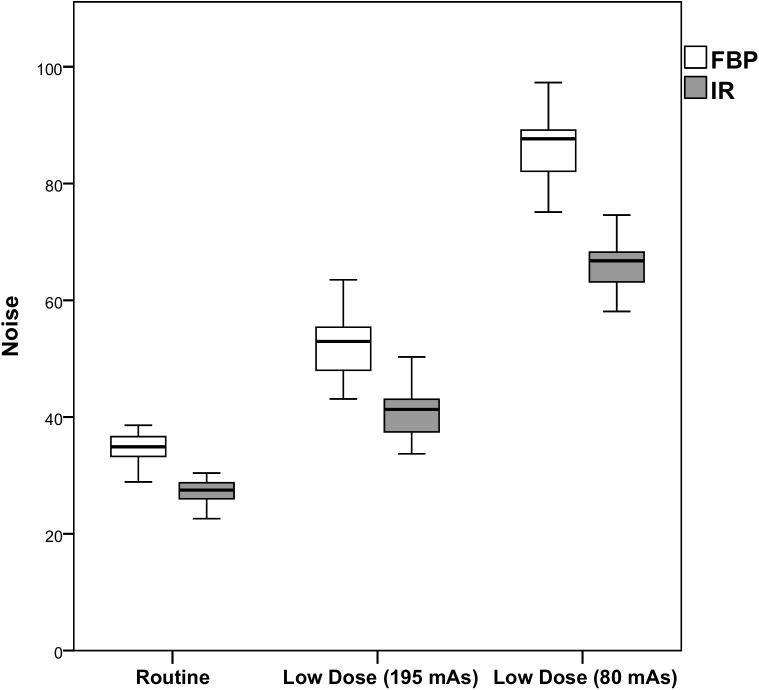
Noise per dose level for FBP and IR.The white boxes represent the noise with FBP, while the gray boxes represent the noise with IR. IR resulted in a decrease in noise compared to FBP at the same dose level. FBP Filtered Back Projection, IR Iterative Reconstruction